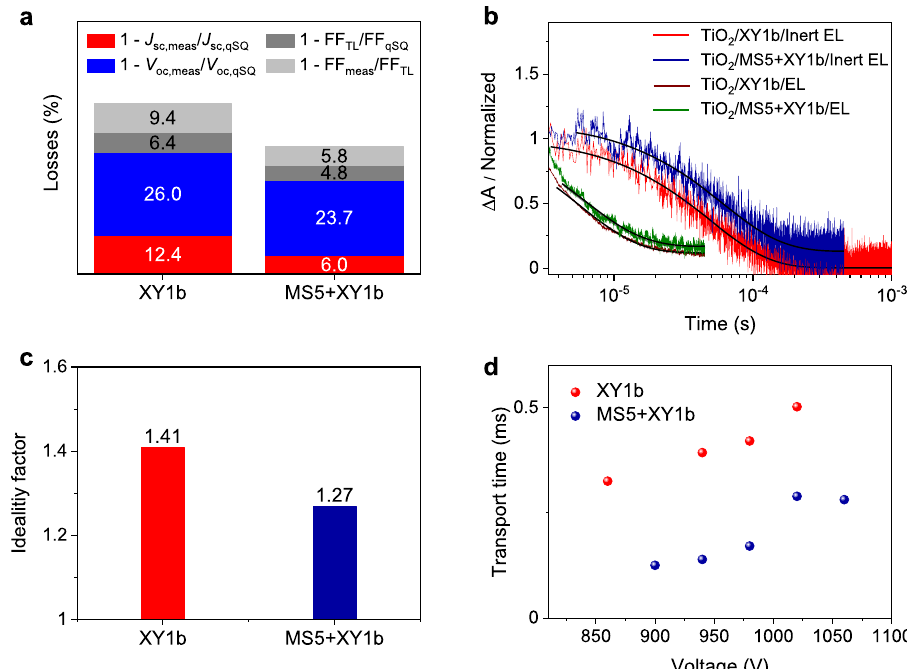
Fig. 4 The loss mechanism of photovoltaic parameters of XY1b and MS5 + XY1b. a Photovoltaic performance losses due to non-ideal absorption (red), non-radiative recombination (blue and dark gray) and charge transport (light gray). The subscripts stand for measured current density – voltage ( J − V ) curve (meas), quasi Shockley – Queisser limit (qSQ), and transport limit (TL). V oc and FF stand for open-circuit photovoltage and fi ll factor, respectively. b Nano- second Flash photolysis measurements of dyes-sensitized TiO 2 fi lms immersed in a [Cu (II/I) (tmby) 2 ][TFSI] 2/1 redox electrolyte (EL) or an inert electrolyte (tmby = 4,4 ′ ,6,6 ′ -tetramethyl-2,2 ′ -bipyridine; TFSI = bis(tri fl uoromethylsulfonyl)imide). The solid lines are monoexponential fi ttings. Pump wavelength: 520 nm; probe wavelength, 815 nm. c The ideality factors of the DSCs based on the dyes XY1b and MS5 + XY1b. d The transport time as a function of applied